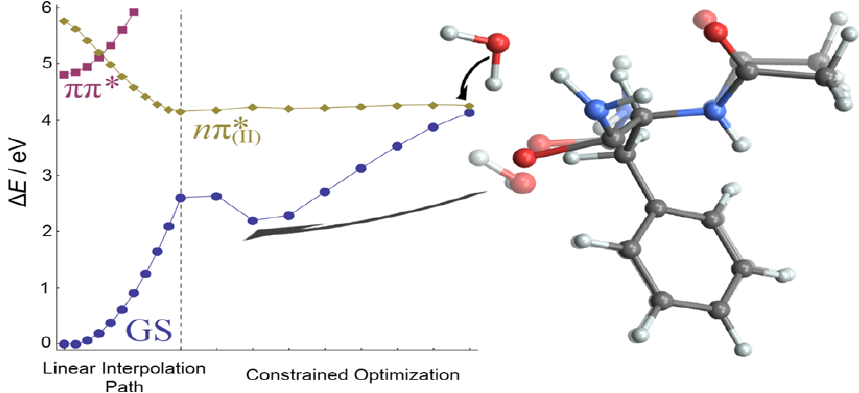
Figure 13. Energy profile showing the deactivation of NAPA B monohydrate. In the first part, interpolation was performed between the M ππ ∗ and M ( II ) minima (left of the dashed line). In the second part, the energy profiles were obtained by constrained optimization in the n π ∗ bond distances. Table 5. Relative energies (eV) and RMSD (Å) of a set of ππ ∗ / n π ∗ with respect to the M ππ ∗